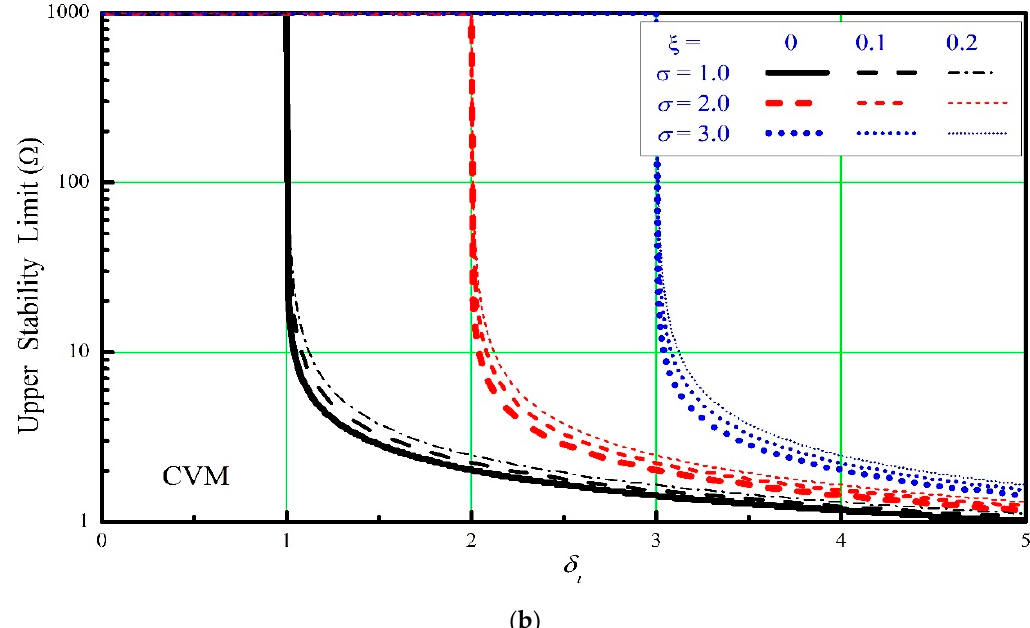
( b ) δ , ( a ) = 0.5 ρ and ( b ) = 1.0. ρ . Figure 2. Variation of upper stability limit with Figure 2. Variation of upper stability limit with δ i , ( a ) ρ = 0.5 and ( b ) ρ = i